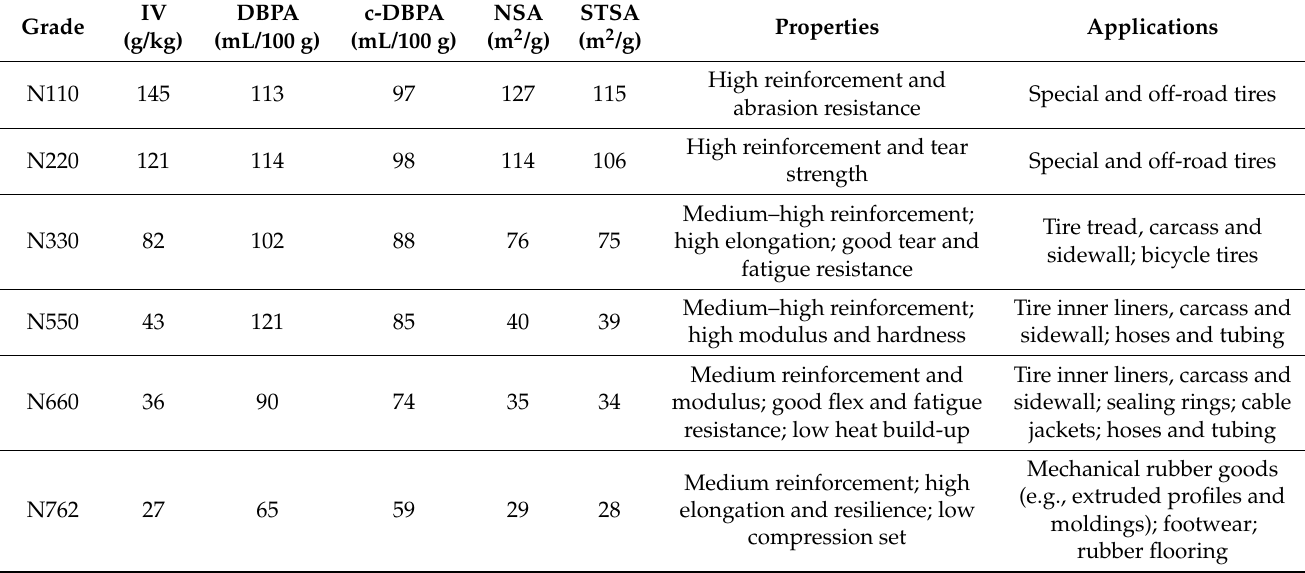
Table 3. Typical descriptive values, properties, and applications of CB grades. Adapted from